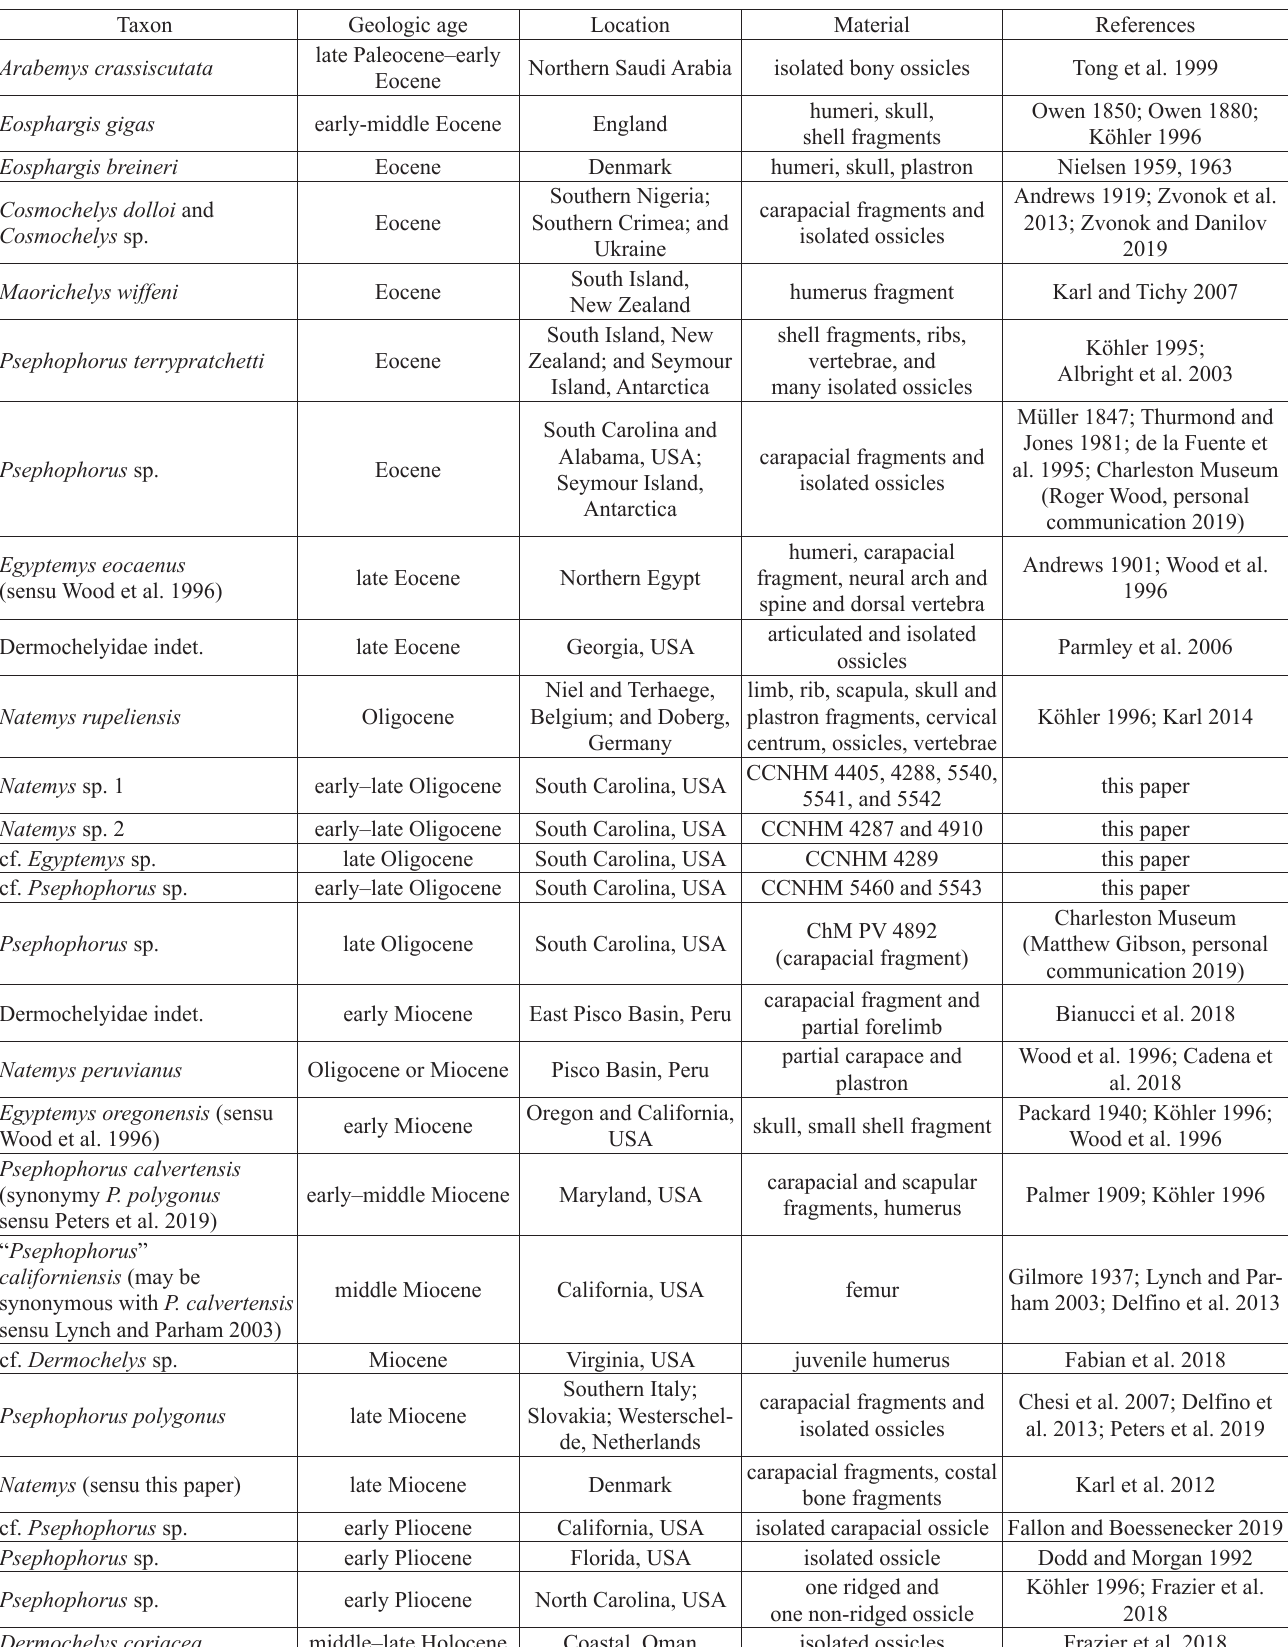
Table 2. All leatherback sea turtle fossils reported for the